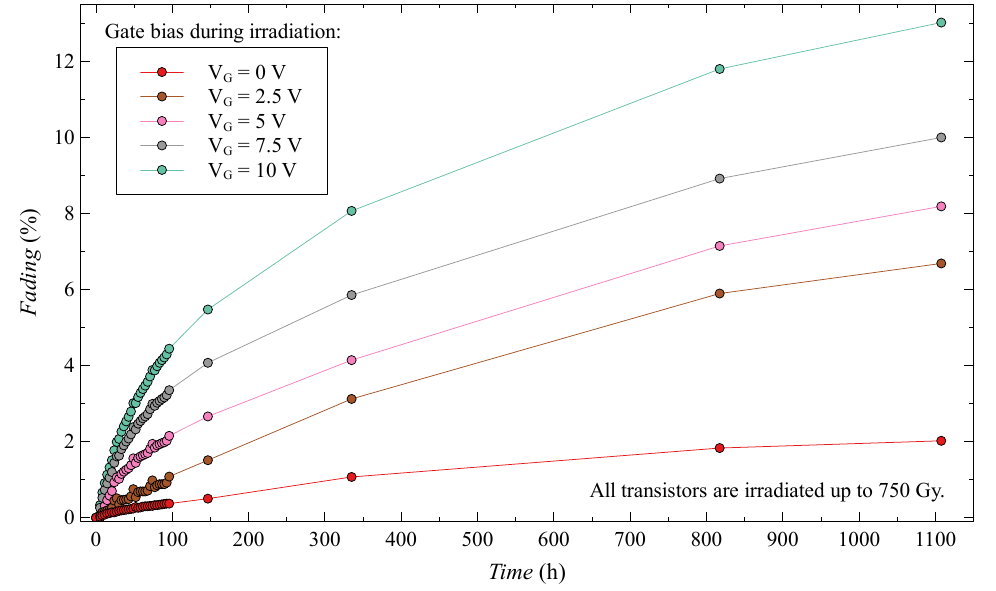
Figure 19. Fading of EPADs with static bias during